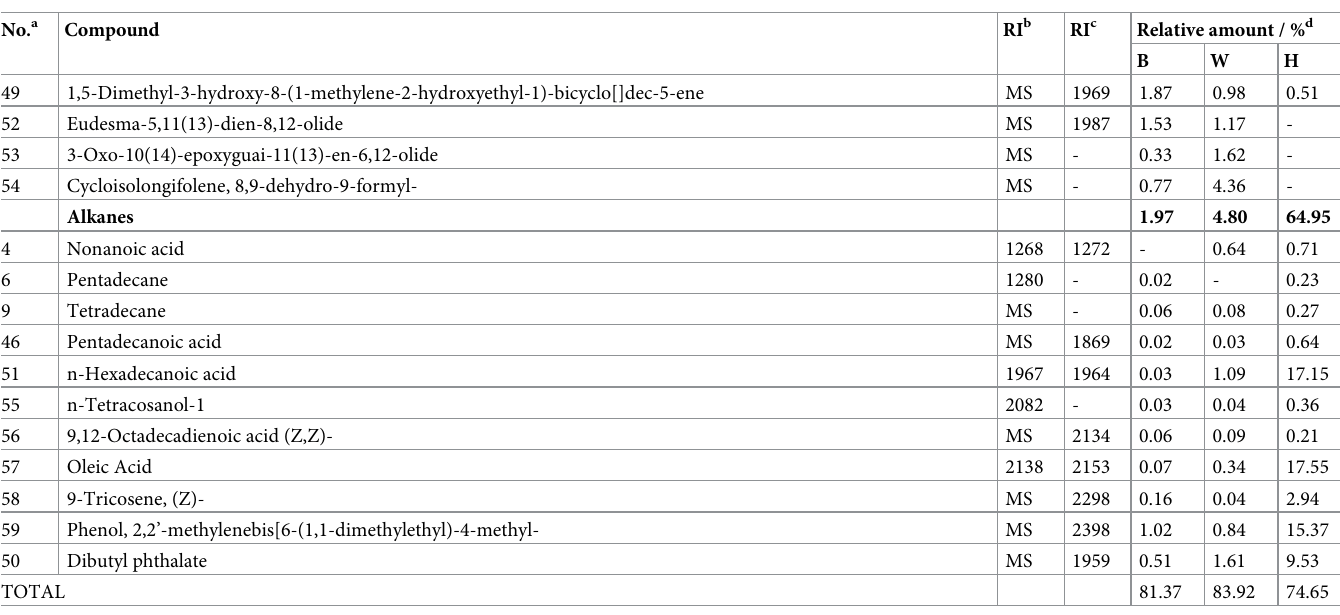
Order of elution is given on HP-5MS b RI indicates reported in the literature for the HP-5MS column c relative amount determined as the peak area relative to the total peak area e not